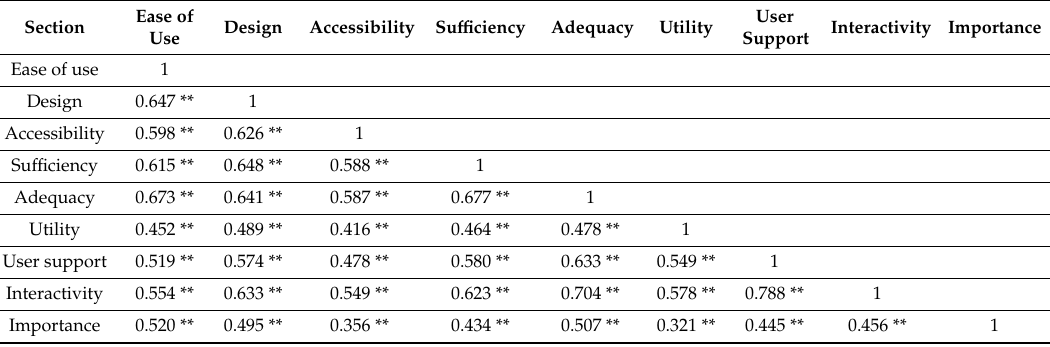
Table 11. Person correlation analysis among the three major variables of